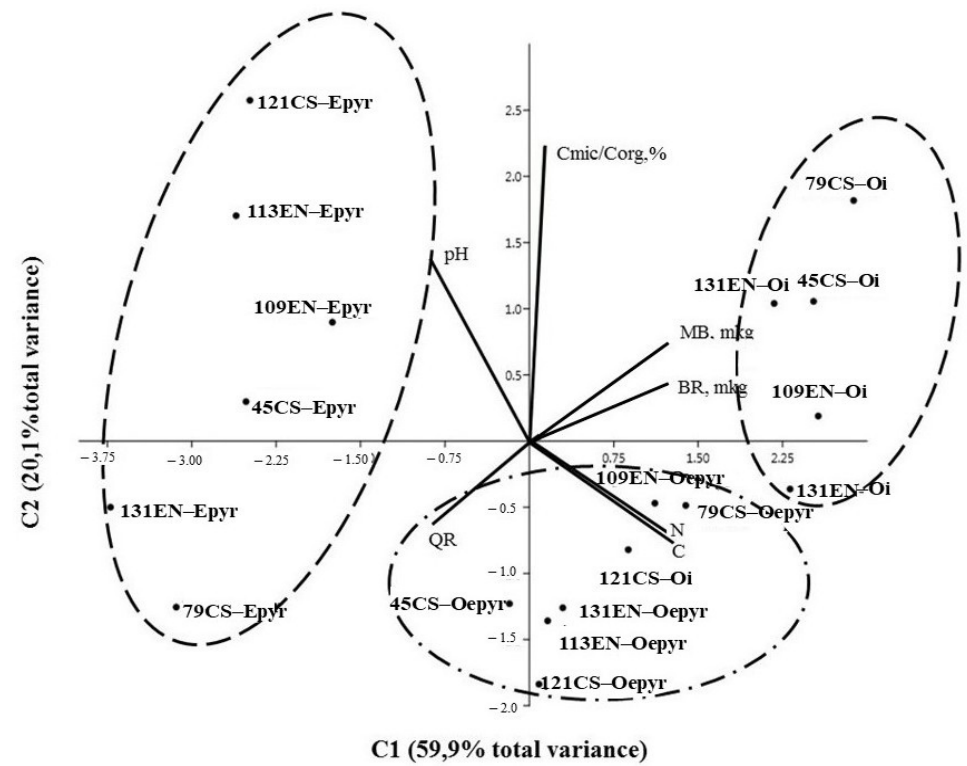
Figure 7. Position of different soil horizons in the plane of the two principal components obtained by the main chemical and microbiological characteristics (averaged data by horizons). Abbreviation: CS—Central Siberia, EN—European North.